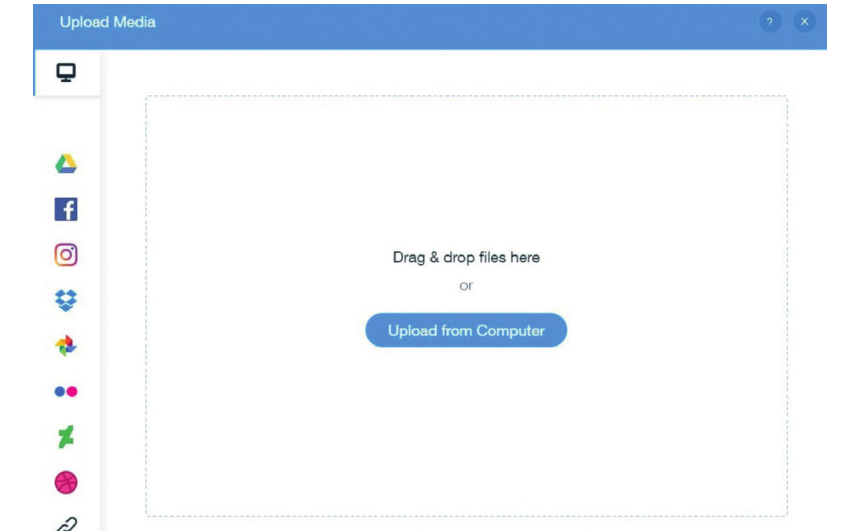
Figure 2: Uploading interface of TRENDMINER.